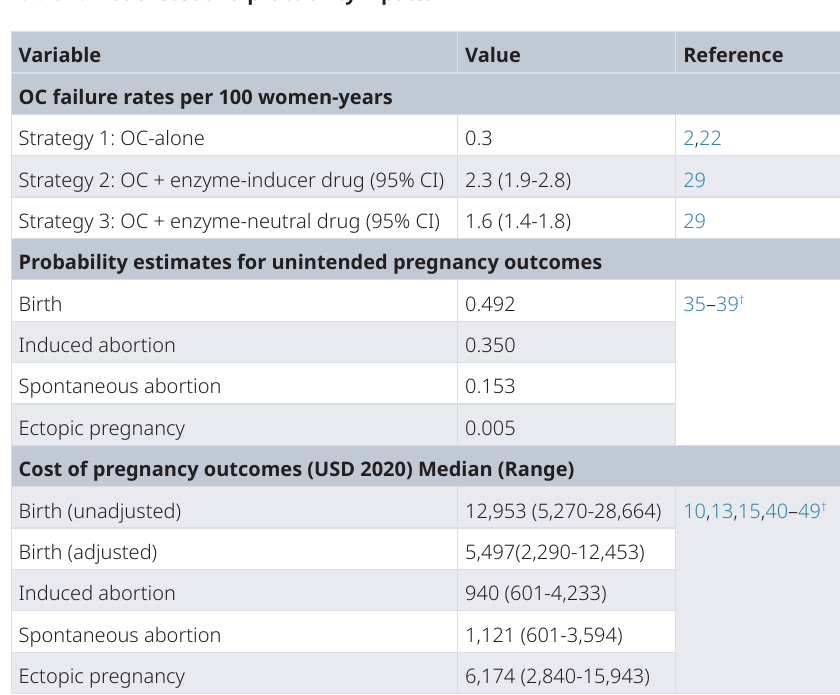
Table 1. Model cost and probability